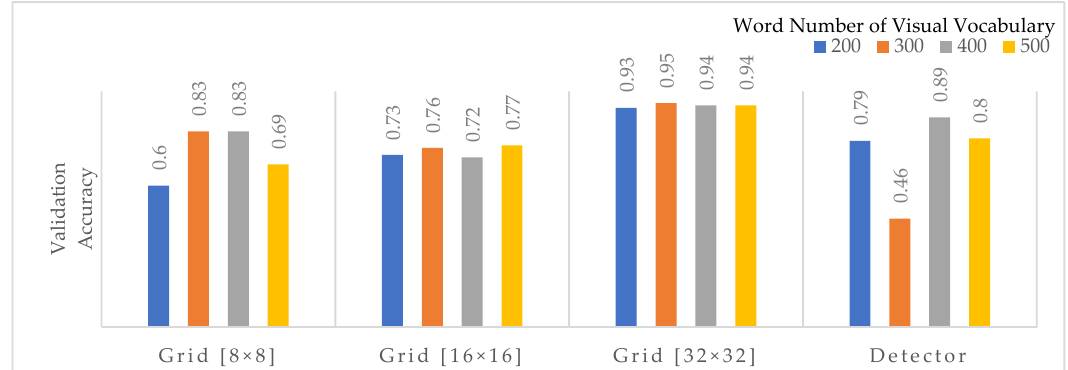
Figure 11. Validation accuracies of recognition model using BOVW feathers with different SURF point selection method.